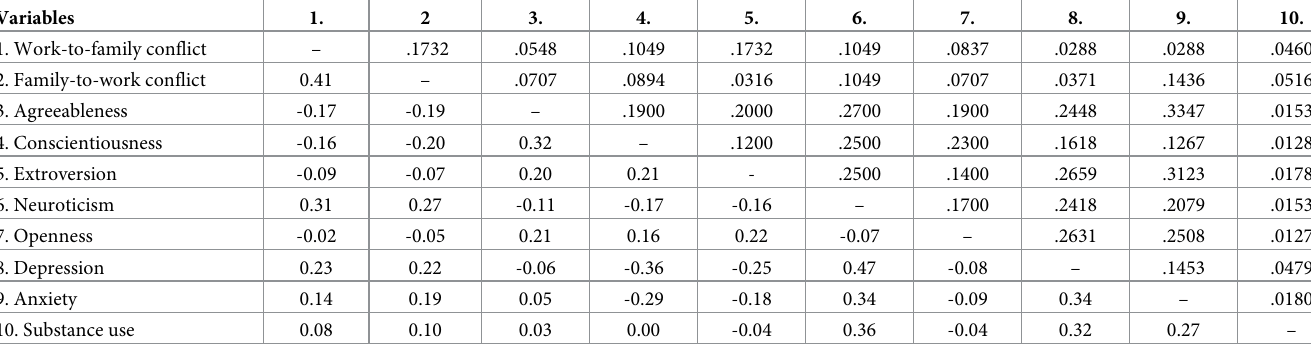
a Correlations are on bottom left side of matrix below the diagonal and standard deviations are on top right side above the diagonal. Harmonic mean = 8942. All non- zero correlations are significant at p <